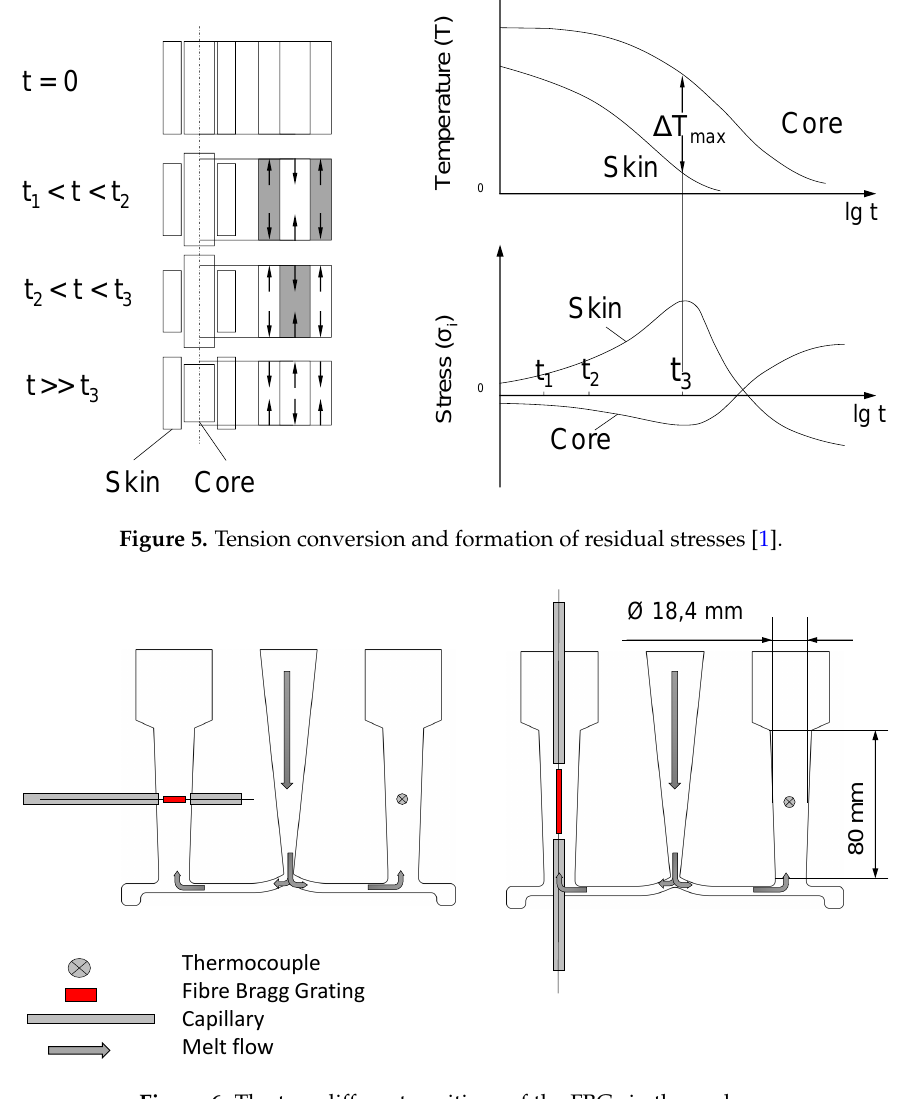
Figure 6. The two different positions of the FBGs in the